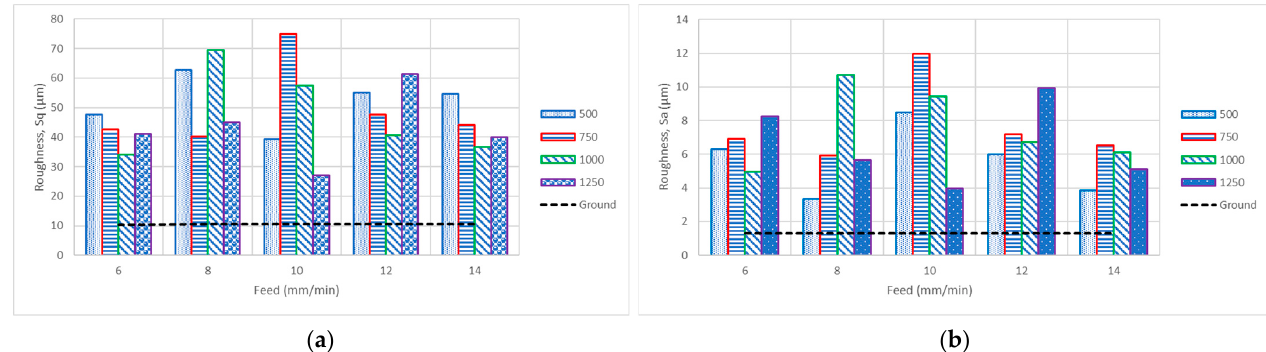
Figure 6. Bar chart of surface roughness for various hardening speeds and feed rates. ( a ) Root mean square height (Sq) and ( b ) arithmetic mean height (Sa).